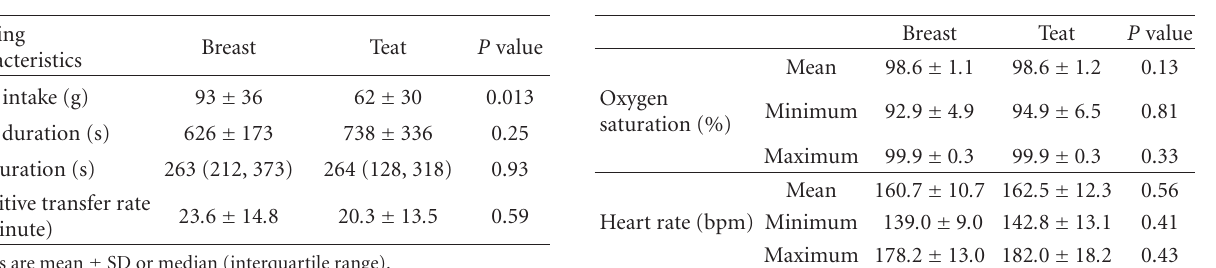
Table 2: Oxygen saturation and heart rate for the monitored breastfeed and the feed from the experimental